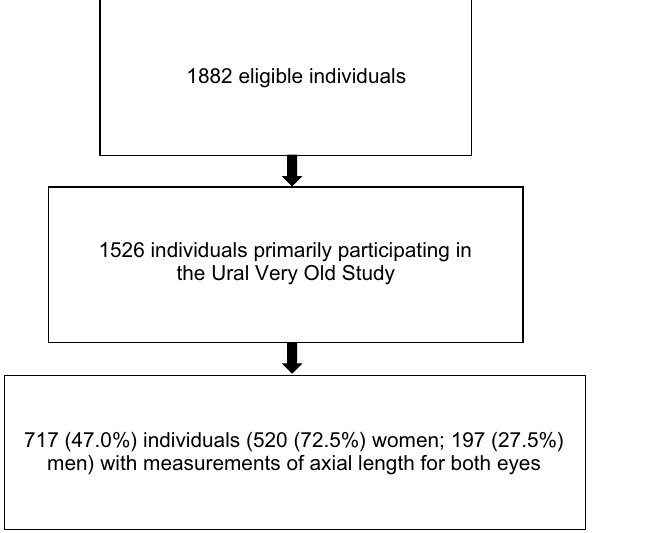
Figure 1. Flow chart of the population of the Ural Very Old Study.